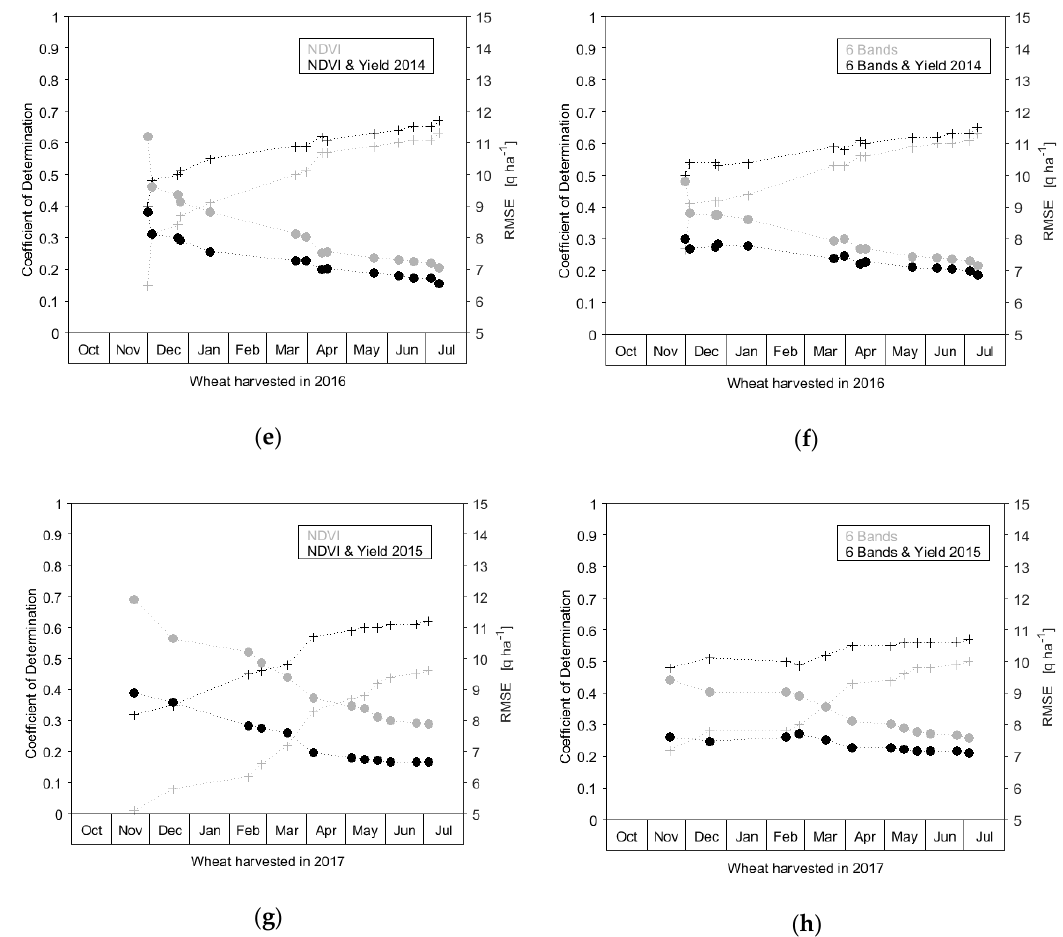
Figure 4. Temporal evolution of the statistical performances (coefficients of determination and root mean square errors, crosses and dots, respectively) associated to the wheat yield forecast using NDVI ( left ) or the combination of six reflectance ( right ), for the years 2014 ( a , b ), 2015 ( c , d ), 2016 ( e , f ) and 2017 ( g , h ).